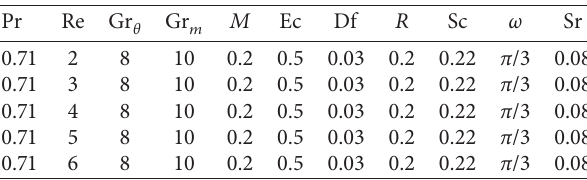
Table 2: Values of the change in Reynolds number.